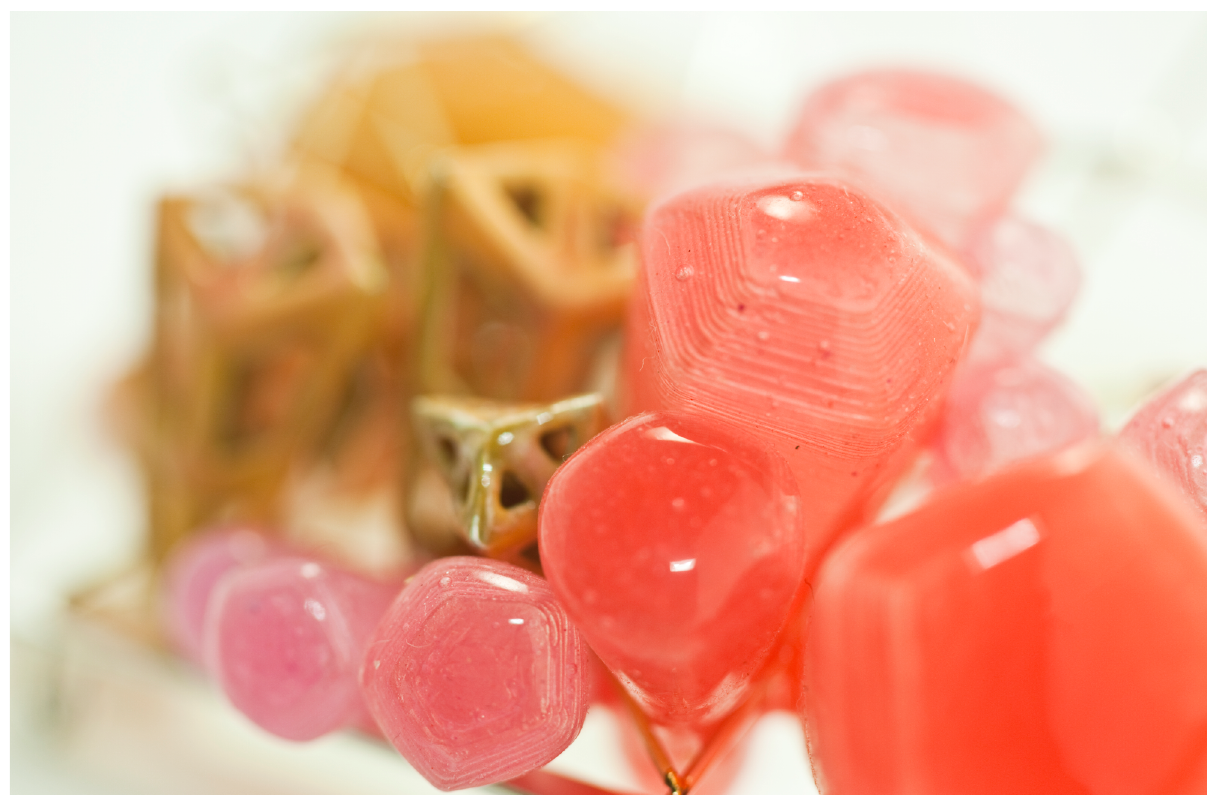
Figure 9 | Xylaria Brooch in its changed state (detail), Katharina Vones